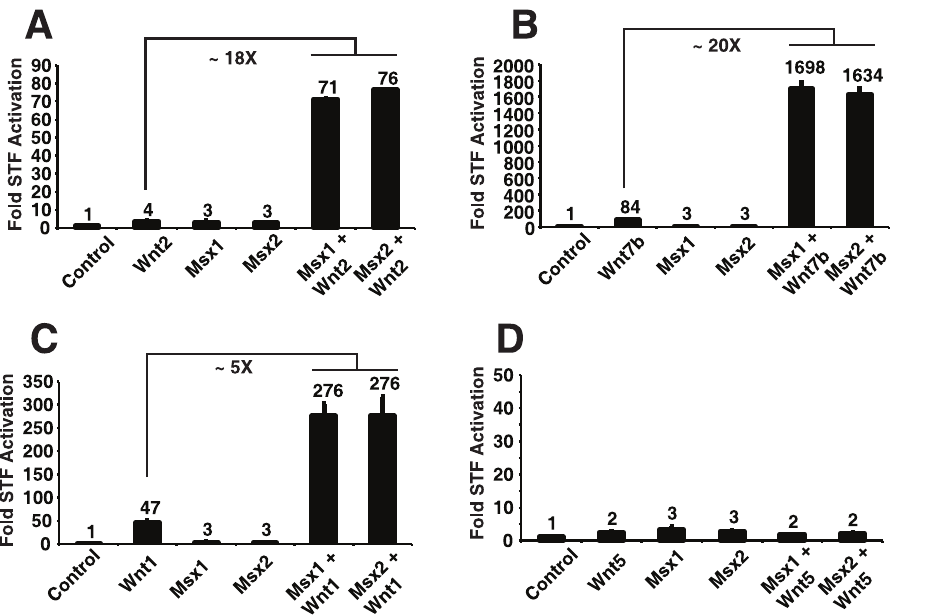
Figure 3. Promotion of cooperative Wnt2-Wnt7b signaling by homeobox transcription factors is Wnt ligand specific. Wnt cooperative signaling assays were performed in RFL6 cells in the presence or absence of Wnt2 (A), Wnt7b (B), Wnt1 (C), or Wnt5a (D). Data represent average of three assays performed in triplicate + S.E.M.